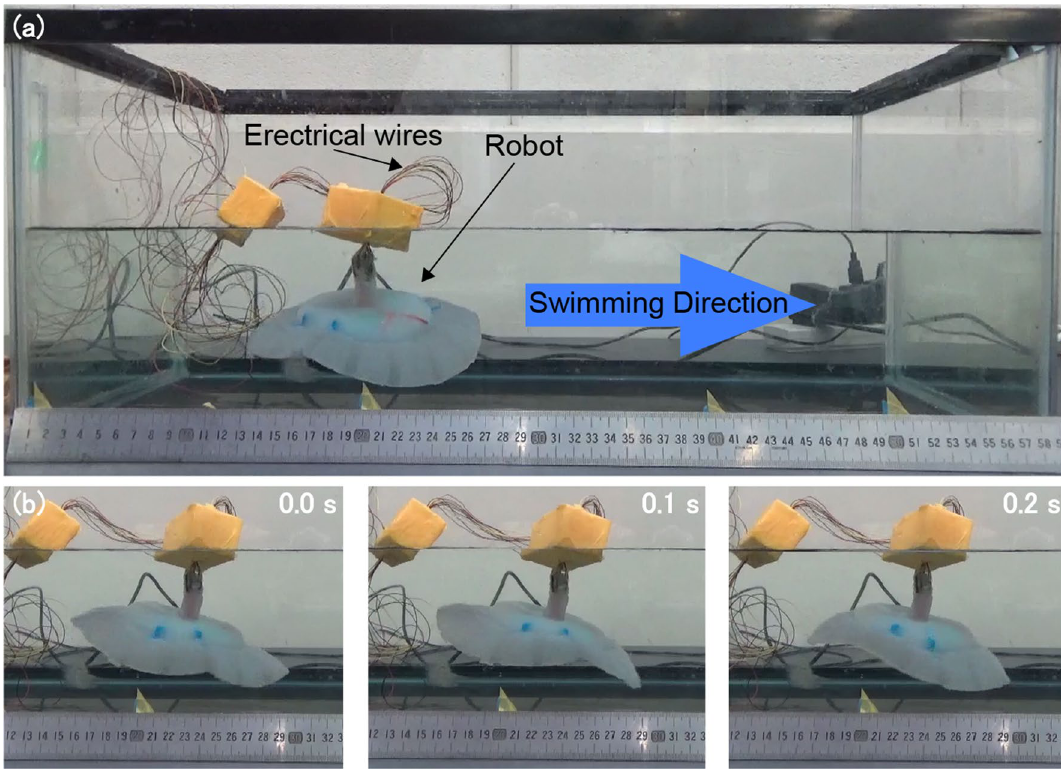
Figure 7. ( a ) Experimental setup to measure the swimming speed and power consumption of the robots; ( b ) sequence of swimming movements of a robot with cartilage structure. Traveling waves are generated by oscillating servomotors from the front to the back of the pectoral fin, thereby realizing swimming of the